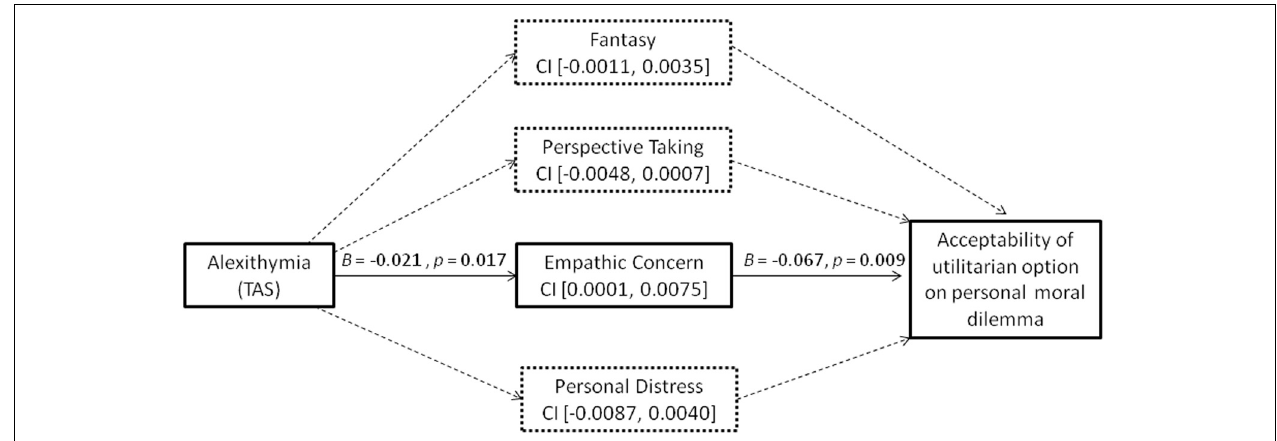
FIGURE 1 | Mediation analysis results. Negative logit coefficient from ordinal regression denotes reduced empathic concern and increased acceptability of utilitarian option on personal moral dilemma. Bias-corrected and accelerated 95% CIs from 20,000 bootstrap samples are reported for